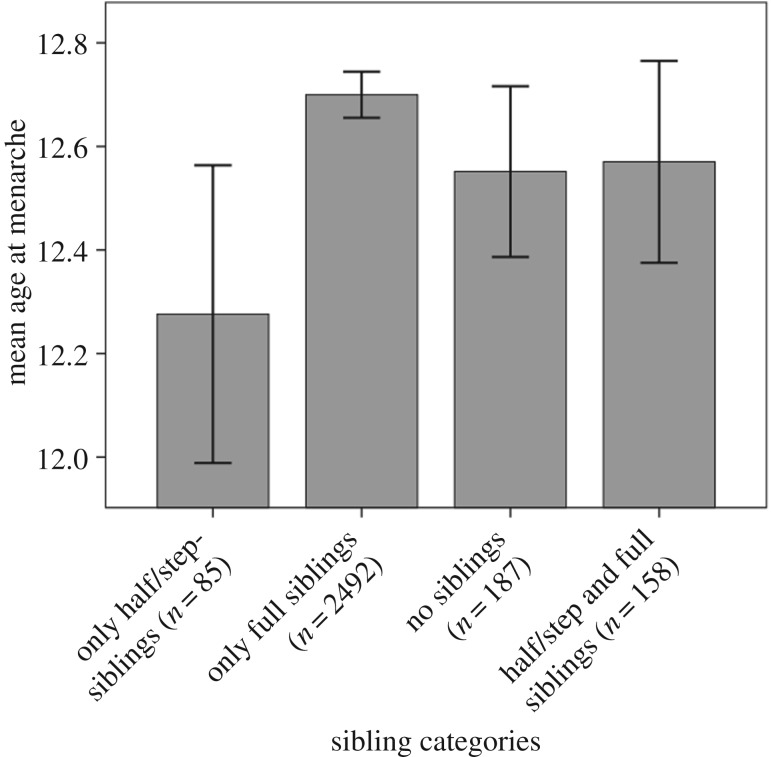
Mean age at menarche for each of the categories of sibling relatedness. Error bars denote 95% CI.